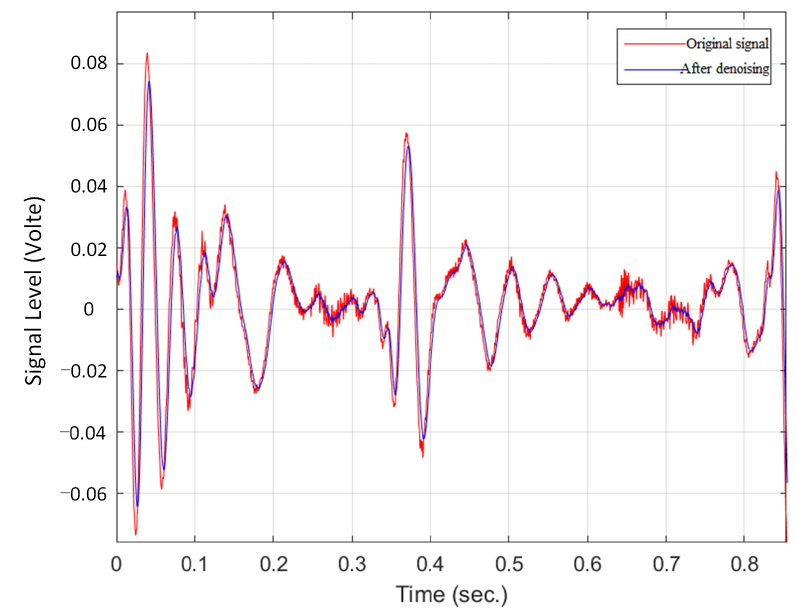
Figure 11. Original and denoising bowel sound signal.